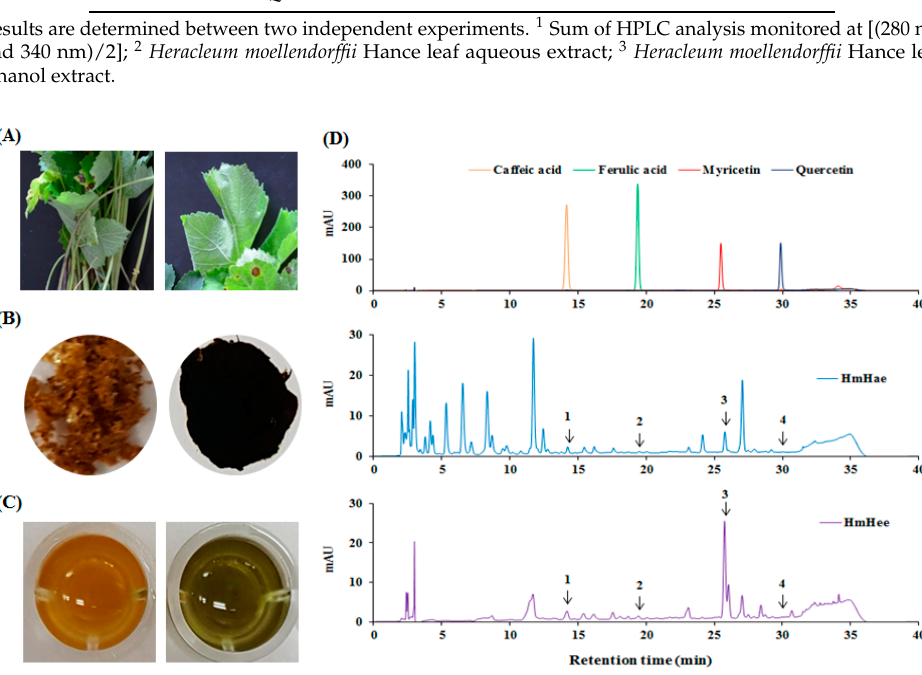
Figure 1. A classical feature of Heracleum moellendorffii Hance and HPLC chromatogram of the extracts monitored at 280 nm. A classical feature of Heracleum moellendorffii Hance leaf ( A ) and its powder ( B ) after fractionation is shown. The HmHae ( left image of C ) and HmHee ( right image of C ) solution were applied to a HPLC column and analyzed characteristic polyphenol compounds ( D ), as described in detail in Materials and Methods. 1 : caffeic acid, 2 : ferulic acid, 3 : myricetin, 4 : quercetin.